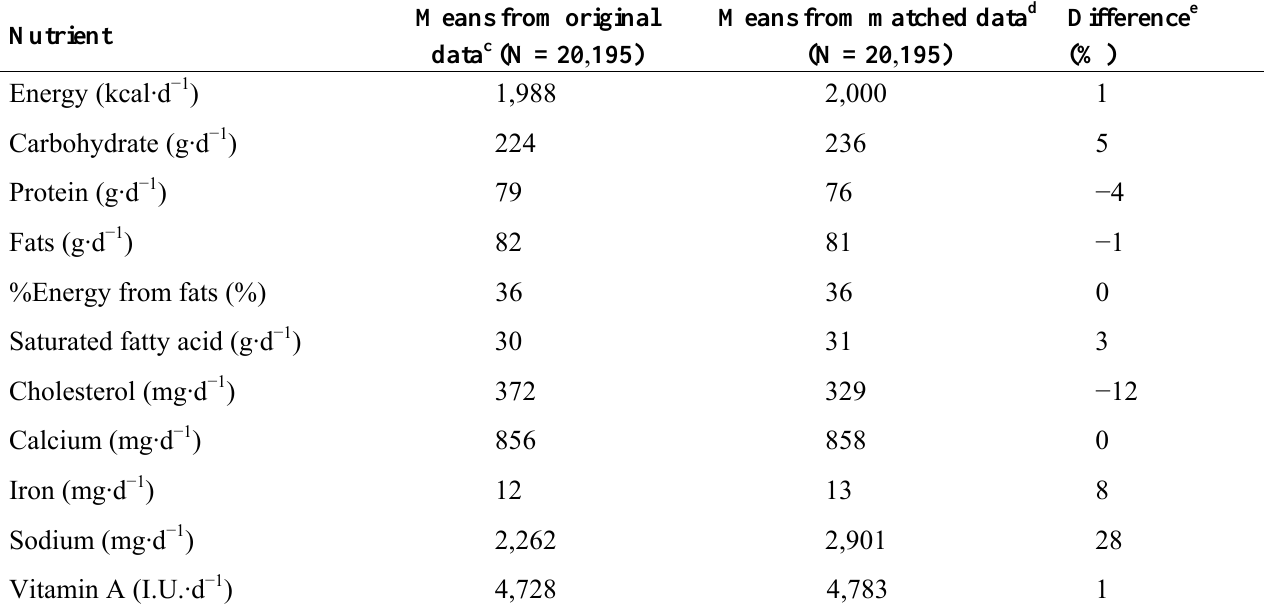
Table 2. Comparison of the mean nutrient intakes of the subjects in the NHANES I estimated based on the original and matched data.